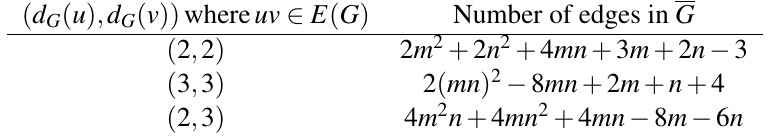
Table 3 The edge partitions m ij of G based on the vertex degrees of G , for n (cid:54) = 1 ( d G ( u ) , d G ( v )) where uv ∈ E ( G )